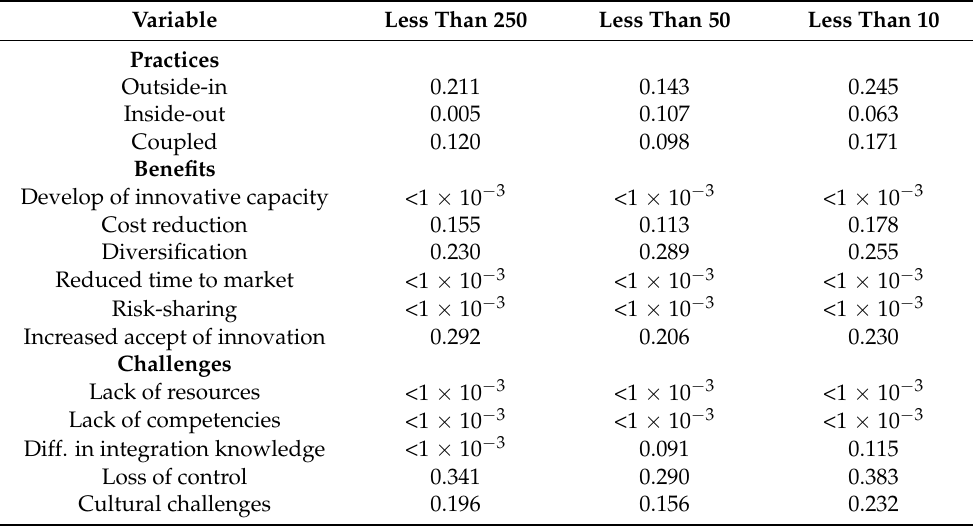
Table 8. ANOVA analysis for the number of